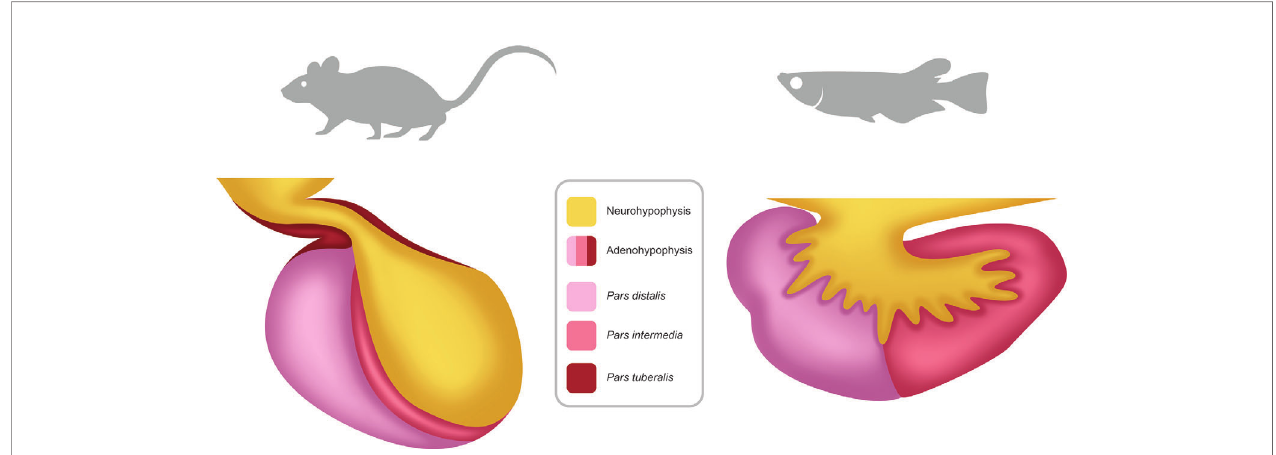
FIGURE 2 | Schema of the pituitary in mammals and teleosts. The pituitary is composed of two main parts: the neurohypophysis (posterior pituitary) and the adenohypophysis (anterior pituitary). The neurohypophysis is mainly composed of neuron terminals from neuroendocrine cells with cell soma located in the preoptic- hypothalamic region of the brain. The adenohypophysis contains different hormones producing cell types and can be anatomically divided in pars distalis , pars intermedia and, in mammals but not in teleosts, pars tuberalis .